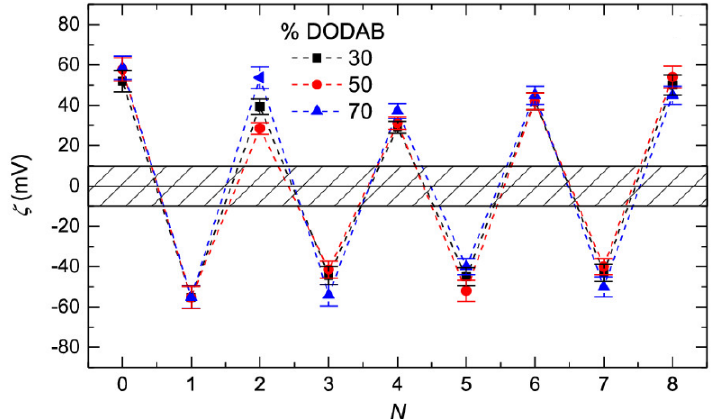
Figure 7. Change in the ξ potential with the alternate deposition of PAH and PSS layers onto positively charged liposomes with different charge density (indicated by %DODAB) from polyelectrolyte solutions with concentration 1 g/L, and ionic strength fixed at 10 mM. Reprinted from Mateos ‐ Maroto et al. [71], Copyright (2021), with permission from American Chemical Society.